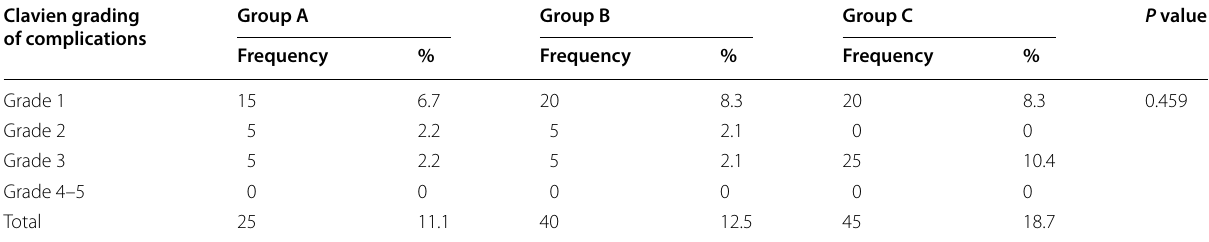
Table 8 Comparison of complications according to Clavien grading Clavien grading Group A of complications